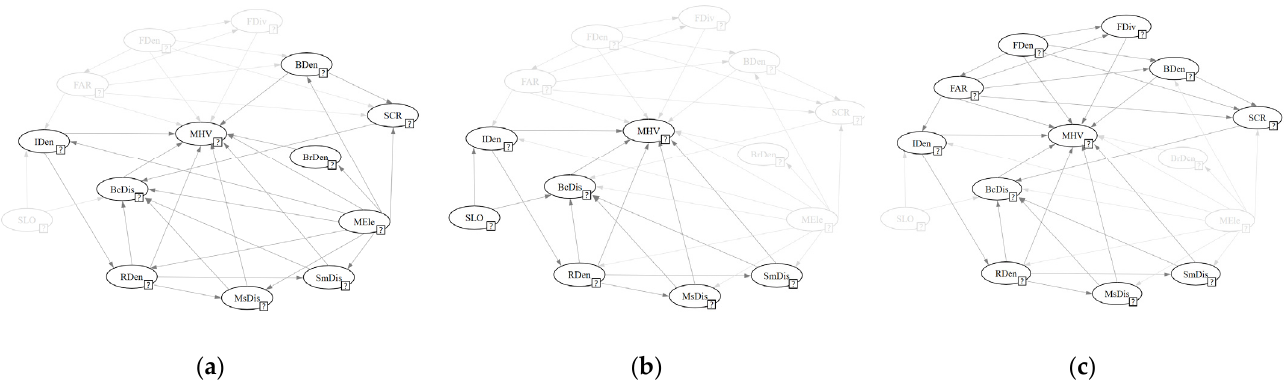
Figure 6. Final Bayesian network structure (note: the three factors of BsDen, GVR and LFac are not related to any other factors in the results, so they are not displayed in the network structure).